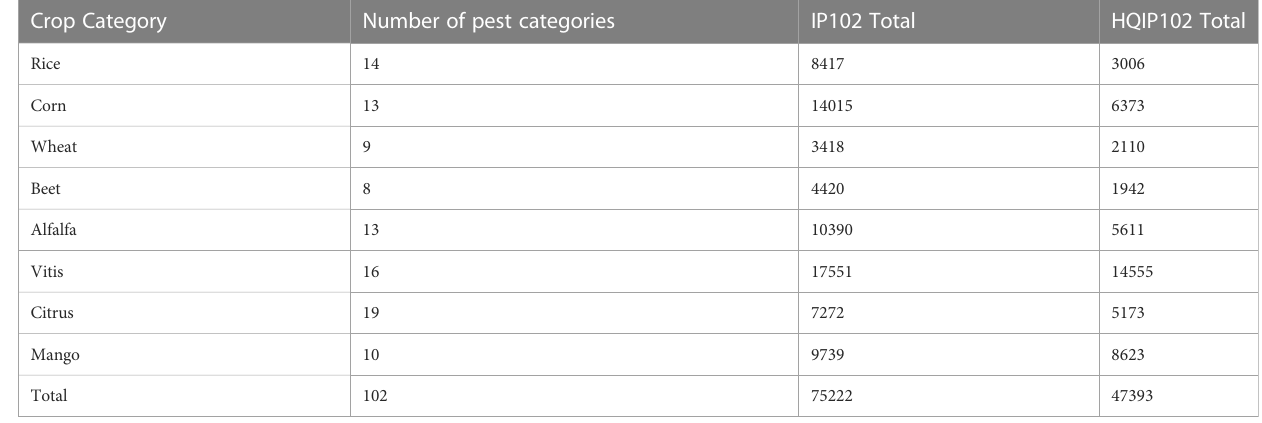
TABLE 1 Comparison of HQIP102 and IP102 on 8 crops. Crop